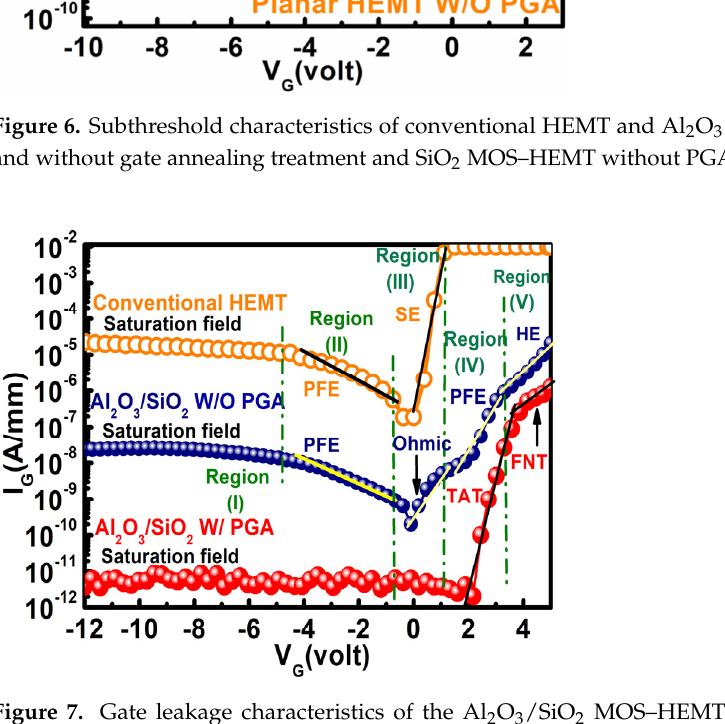
Figure 6. Subthreshold characteristics of conventional HEMT and Al 2 O 3 /SiO 2 MOS–HEMT with and without gate annealing treatment and SiO 2 MOS–HEMT without PGA treatment.